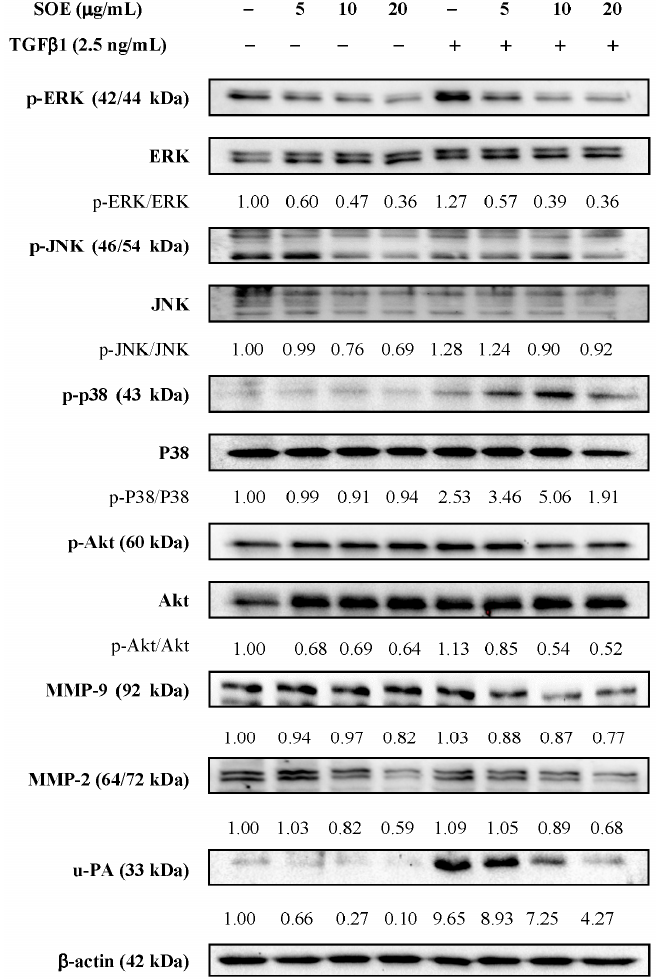
Figure 6. Western blot analysis of migration and invasion-related proteins in RL95-2 cells treated with different concentrations of SOE for 24 h. Whole-cell lysates were subjected to Western blot assays and β -actin was used as an internal control. The relative density of the proteins was determined by densitometric analysis. The values indicate the density proportion of each protein compared to that without TGF β 1 induction and without SOE treatment.